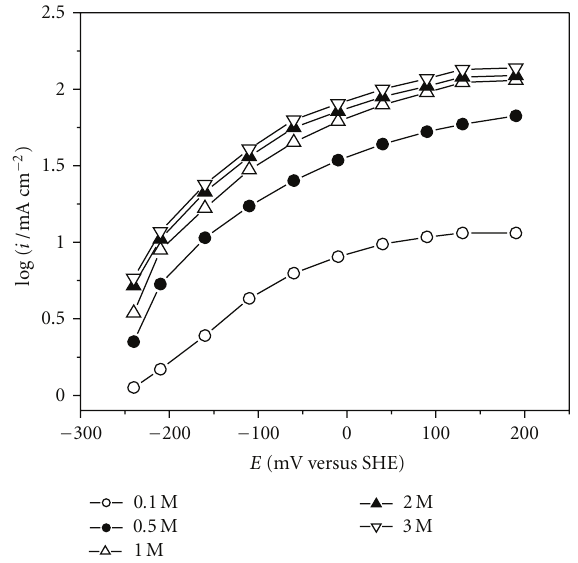
Figure 9: Potentiostatic polarization plots for methanol oxidation on Pt-Pd/C electrode in1.0M methanol at various NaOH concen- trations at 25 ◦